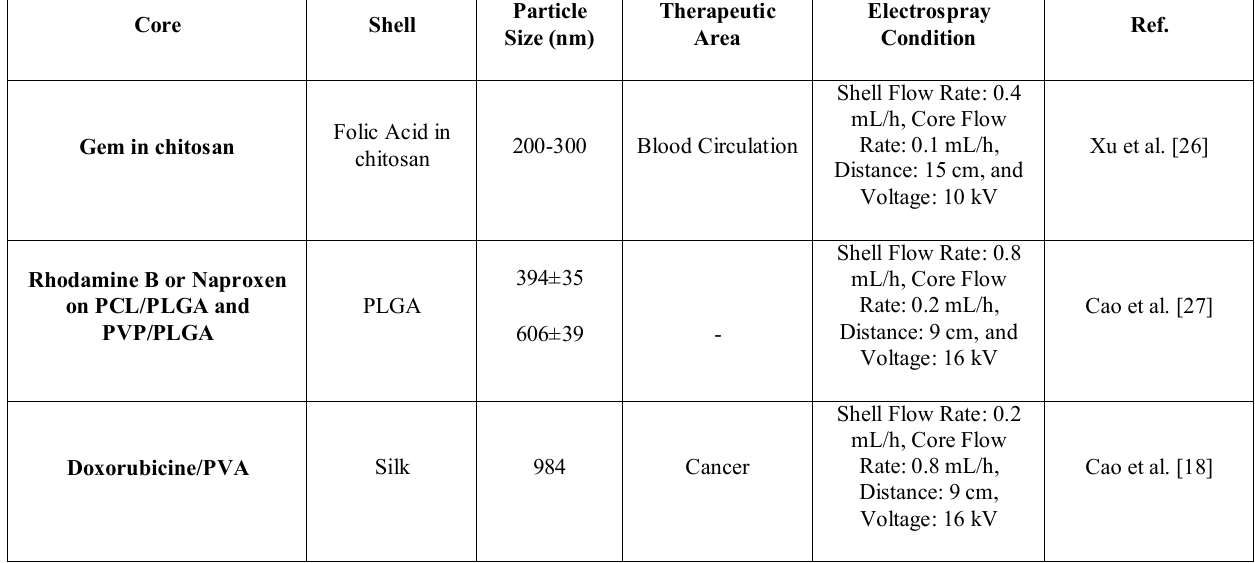
Table 1: Electrosprayed core-shell structures loaded by various materials applicable as targeted drug release